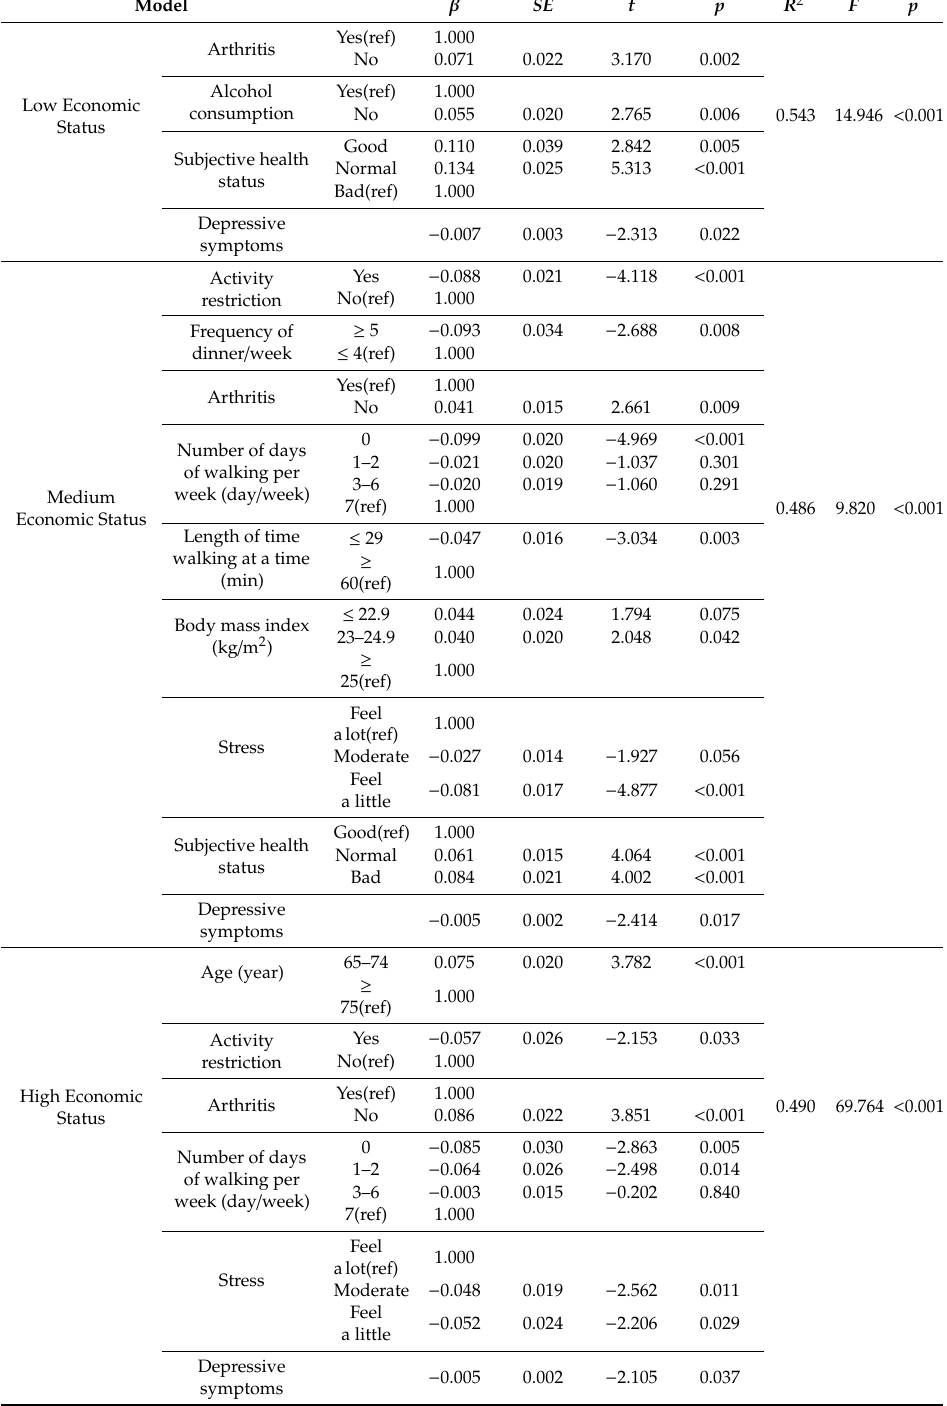
Table 3. Linear Multiple Regression of Factors Influencing Quality of Life by Economic